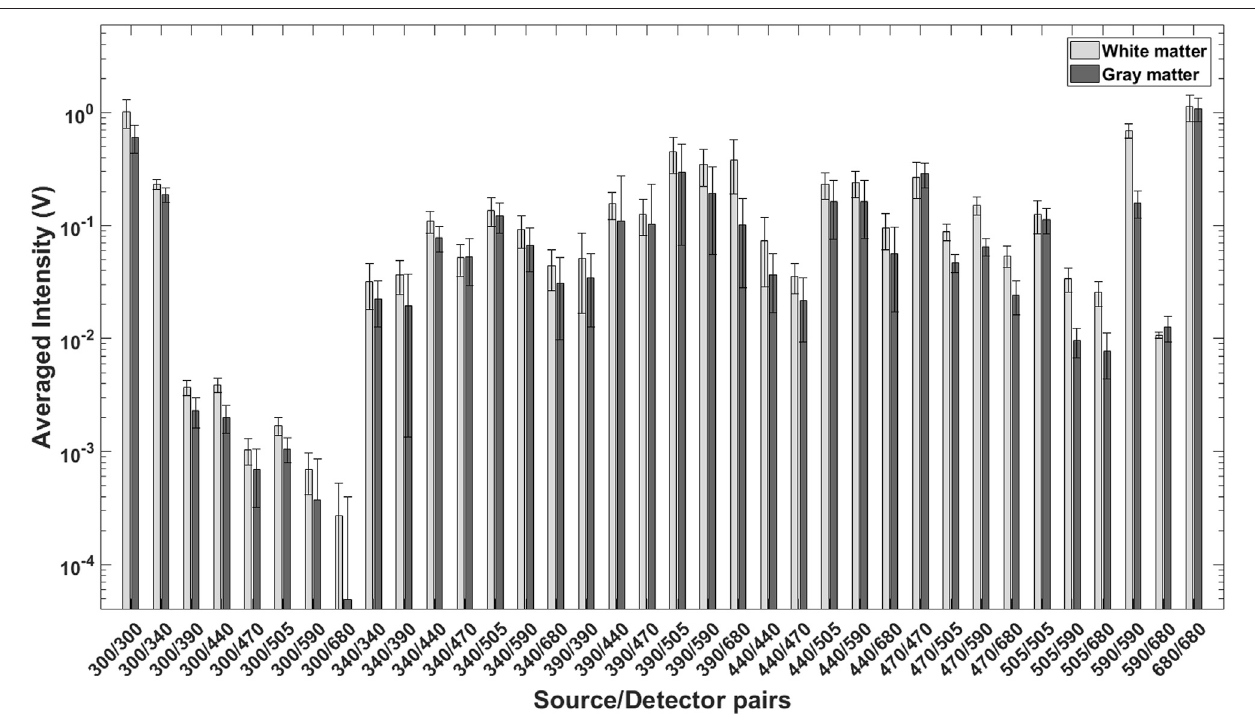
FIGURE 8 | Average, mean normalized light intensities for 36 source detector pairs collected from White ( n (cid:1) 101) and Gray ( n (cid:1) 129) matter of sheep brain. This data was used for SVM classi fi cation.